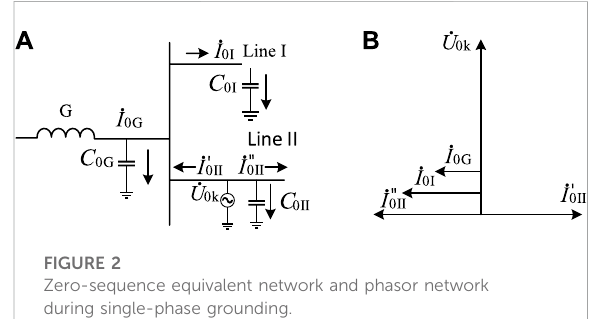
FIGURE 2 Zero-sequence equivalent network and phasor network during single-phase